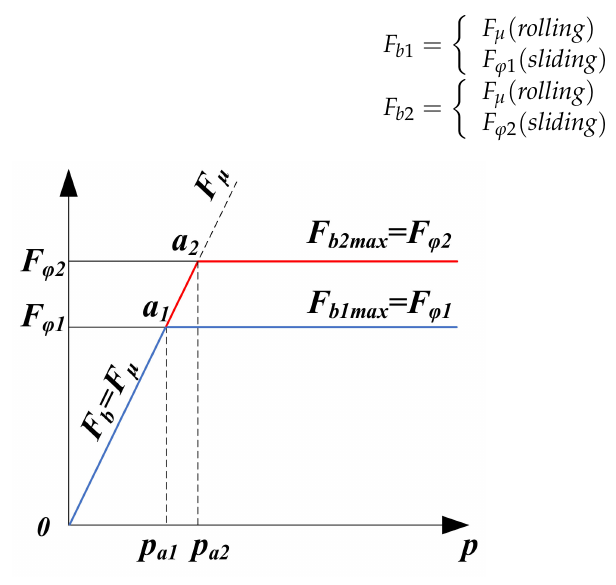
Figure 10. Ground braking force of the tracks on both